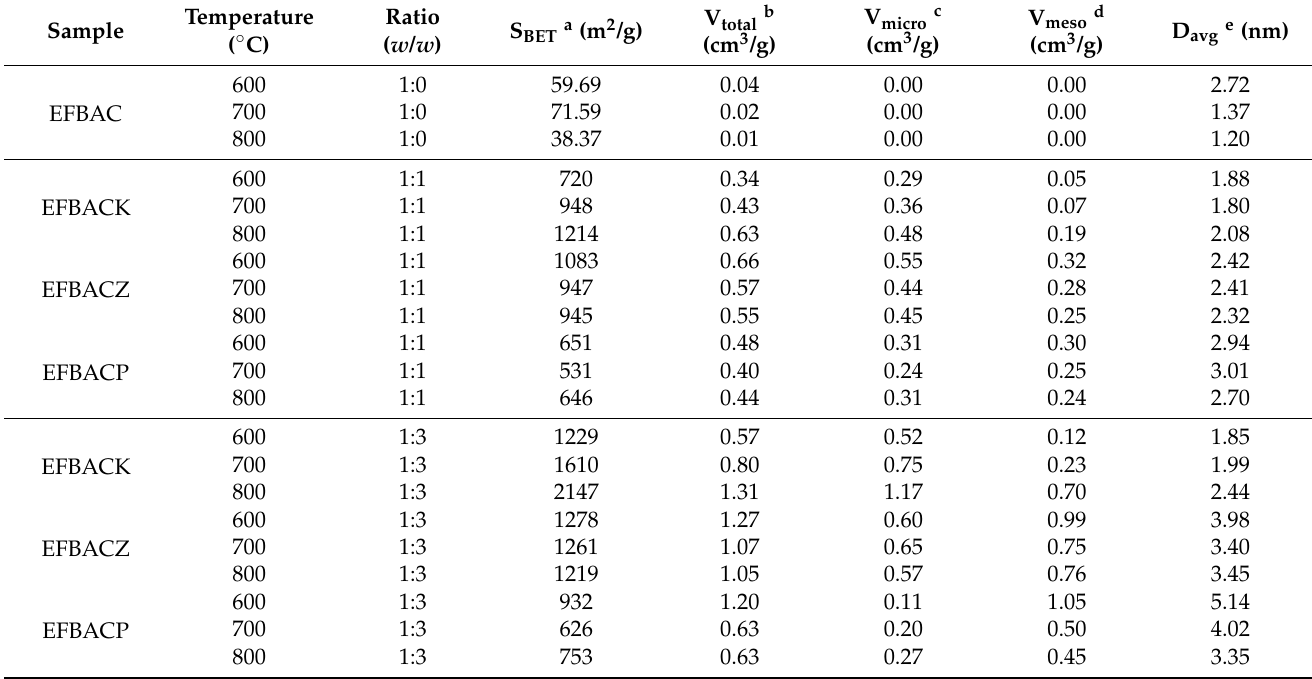
Table 6. BET surface area of empty fruit bunch activated carbon prepared at various